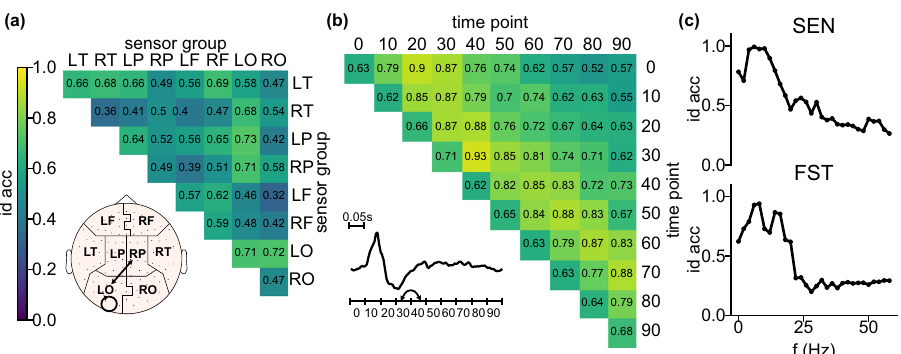
Fig. 7 Identi fi cation accuracy of components of the features. See Supplementary Fig. 11 for ( a , b ) on FST data. a Identi fi cation accuracy of the sub-features of sp on SEN data. Each grid represents the identi fi cation accuracy using the corresponding entries of sp averaged across cross-sessions ( N = 6), individuals ( N = 4), and identi fi cation runs ( N = 100). Inset is the plot of the sensor group layout and edges correspond to the sensor group pair with over 0.7 accuracy for both FST and SEN. The topomap was plotted using the python MNE package 49 . b Identi fi cation accuracy of the sub-features of tp on SEN data. Each grid represents the identi fi cation accuracy using the corresponding entries of tp averaged across the same dimensions as in ( a ). Inset is an example MEG signal of one individual averaged across channels ( N = 102) and trials ( N = 1000). Arrows correspond to the entries of the heatmap with over 0.9 accuracy for both FST and SEN. c Identi fi cation accuracy of the sub-features of fq on SEN (upper plot) and FST (lower plot) data. Each dot represents the identi fi cation accuracy using the corresponding entries of tp averaged across cross-sessions ( N = 6 for SEN and 12 for FST), individuals ( N = 4), and identi fi cation runs ( N = 100). Accuracy values of f larger than 60 Hz were truncated since the curve became fl at. Error bars are SE across cross-sessions, individuals, and identi fi cation runs and are invisible due to small values. The curve peaks at f = 6 Hz for SEN and f = 8Hz for FST. The accuracy of some components of a feature is consistently higher than the rest on both datasets, indicating that some parts of a certain feature may be more important in identifying